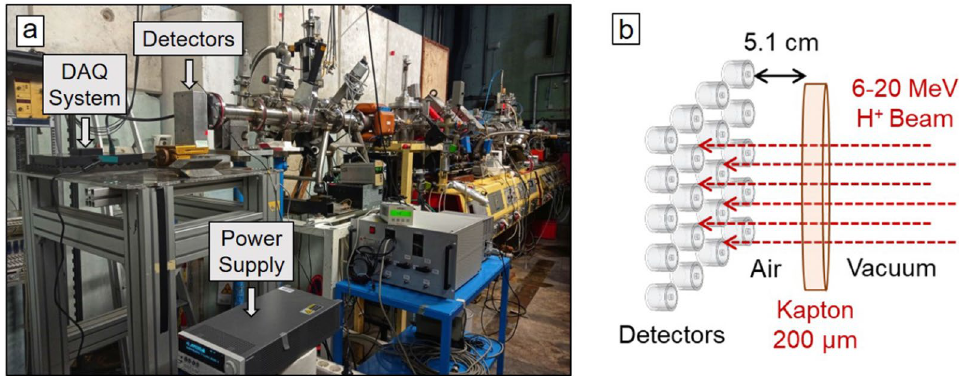
Figure 3. ( a ) Experimental setup used for the irradiations at the beamline 410 of ALTO. The distance between the front face of the detectors and the exit window of the beamline was 5.1 cm. ( b ) Sketch of the irradiation